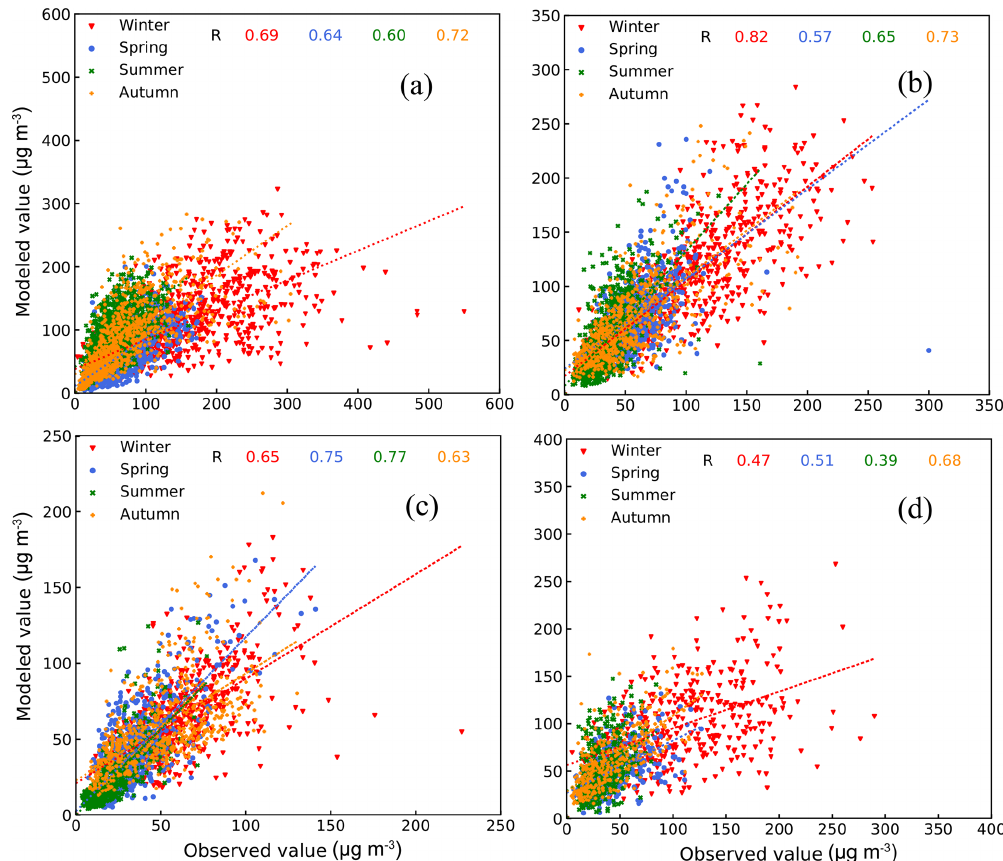
Figure 3. Scatter plots and correlation coefficients of daily PM 2 . 5 concentrations between observed and simulated values in different seasons in the (a) NCP, (b) YRD, (c) PRD, and (d) SCB